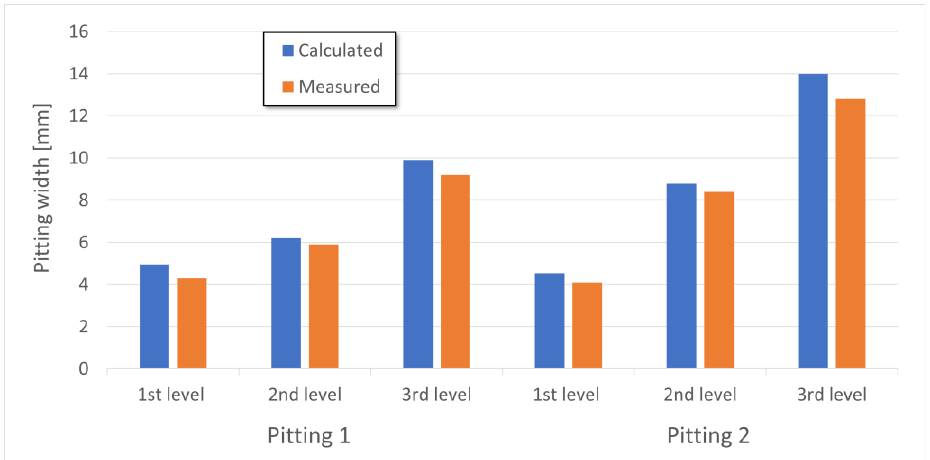
Figure 7. Comparison of the measured and the calculated results for Pitting 1 and 2 in the x direction.